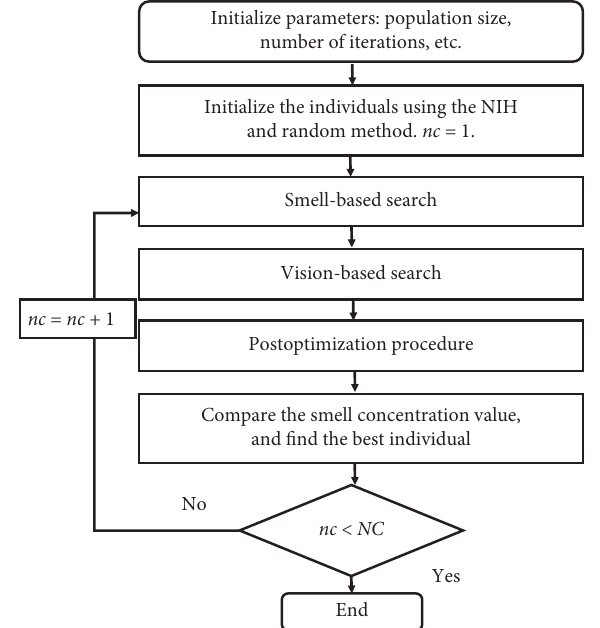
Figure 8: Flowchart of the HFOA for FSSP. Table 1: Instance